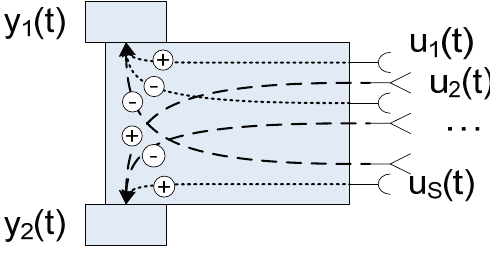
Figure 19. Braitenberg vehicle 3.c with the different input: sensor sources U x (t) and the two outputs: motors Y 1 (t) and Y 2